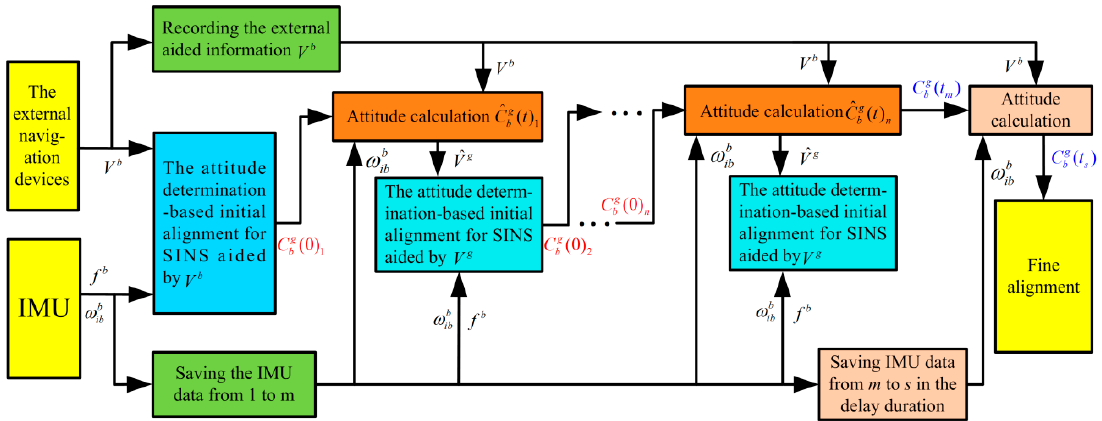
Figure 5. Block diagram of proposed multistage attitude determination alignment with different velocity models.